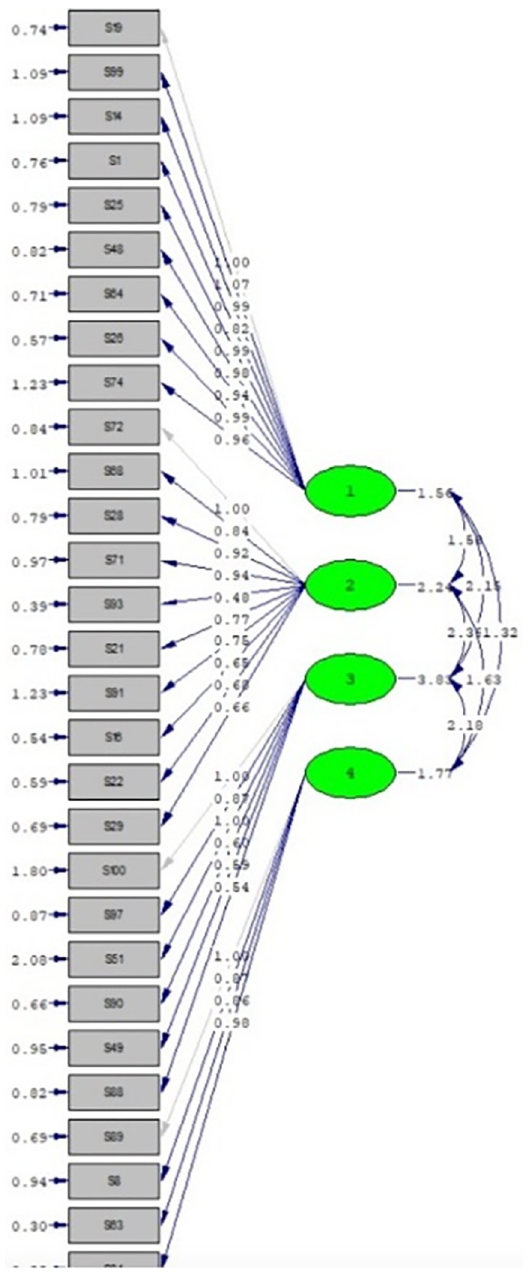
Fig 2. Four factor structure of the PBQ based on the results of CFA. Four factors were retrieved from the FA and can be seen as 1 to 4, which were named as follow: Social Participation and Interpersonal Relationships, Autonomy and Role, Subjective Satisfaction with Participation, Recreational, Sport, and Leisure Time. Each subscale was formed with a group of items from the original questionnaires, which can be seen in gray rectangles. All the subscales are intercorrelated, as can be seen with arrows among subscales. The correlation between each item and the subscale can be followed with the arrows.